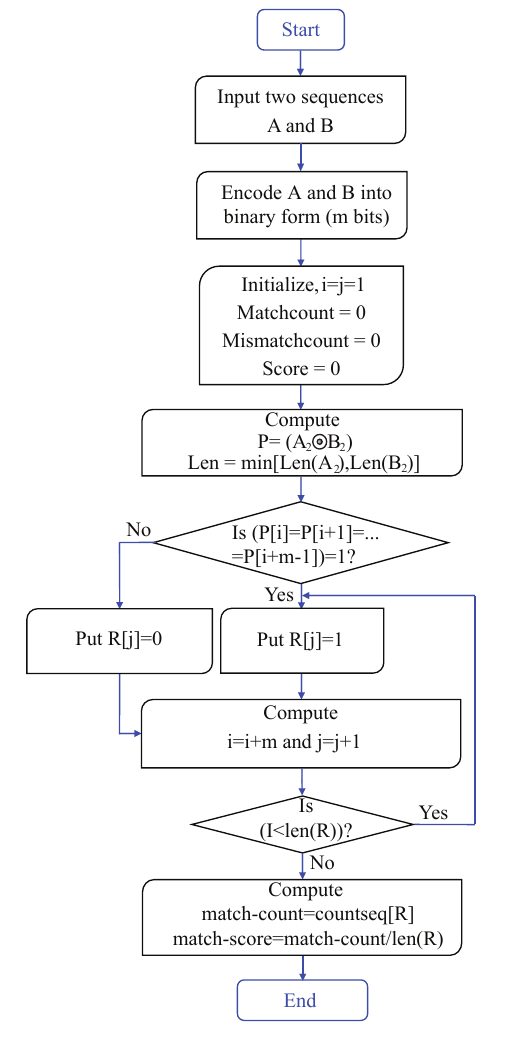
Figure 5. Flowchart of DNA hybridization in two samples A and